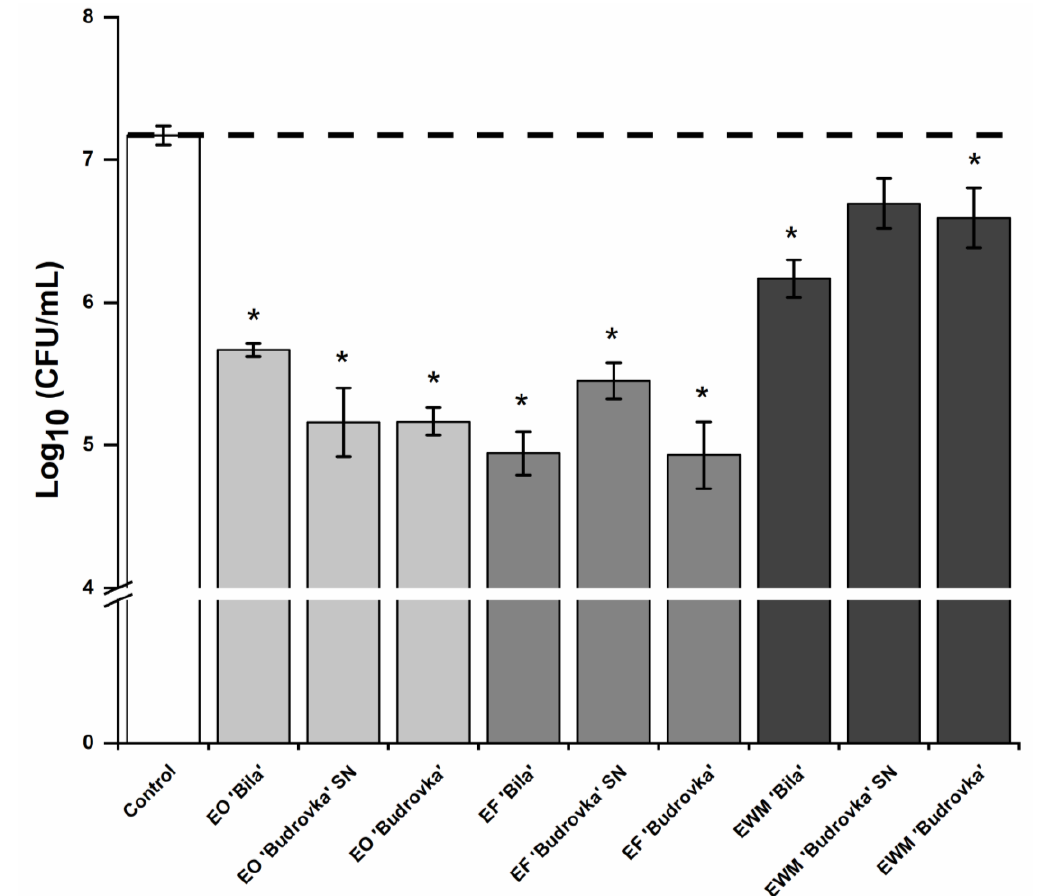
Figure 2. Effect of different lavandin formulations (EOs, EFs and EWMs) at subinhibitory concen- tration (0.25 × MIC) on the adhesion of C. jejuni NCTC 11168 to a polystyrene surface. C. jejuni NCTC 11168 was cultivated in a polystyrene microtiter plate without or with the addition of lavandin for- mulations at subinhibitory concentration in a micro-aerobic atmosphere at 42 °C for 24 h. Attached cells were suspended by sonication and their concentration was determined by plate counting. Log 10 average values ± SD are shown. * p < 0.05, vs. control. (EO, essential oil; EF, ethanolic extract prior to distillation; EWM, ethanolic extract of post-distillation waste material).